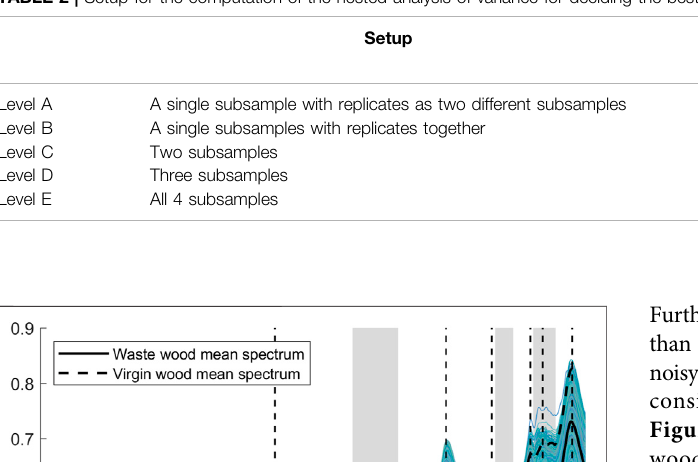
TABLE 2 | Setup for the computation of the nested analysis of variance for deciding the best sampling procedure.